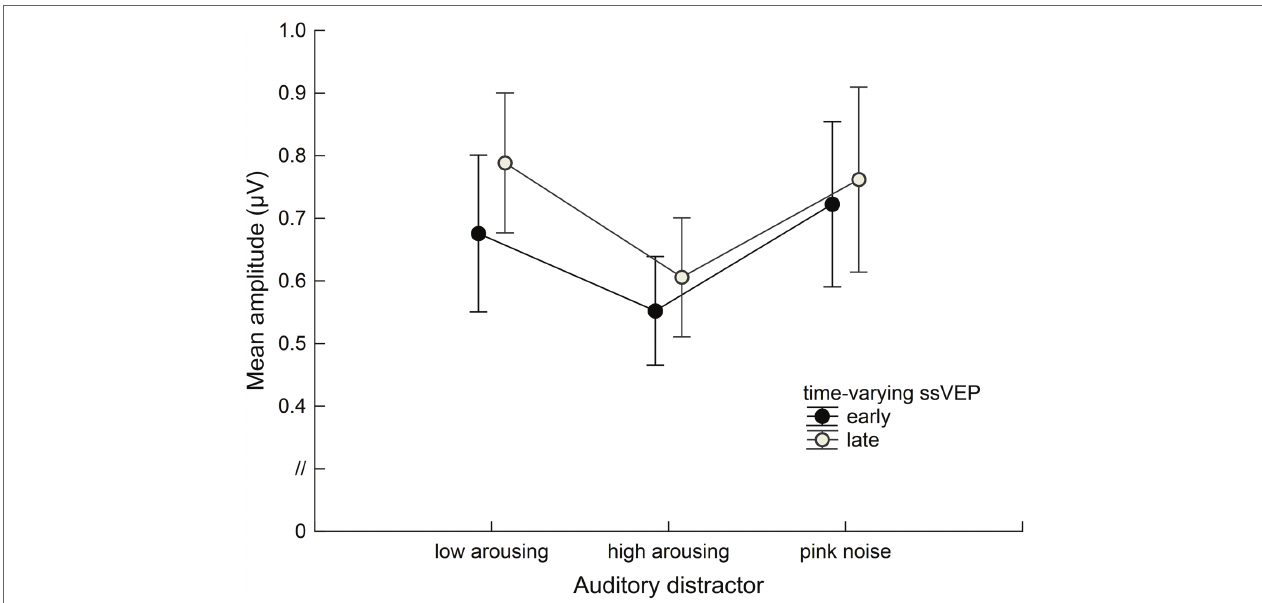
FIGURE 6 | Group data ( n = 20) for the time-varying ssVEP signal in the early and late time ranges. Mean amplitudes to the math-problem stream are shown as a function of auditory distractor type during early (400–2,600 ms) and late (3400–5,600 ms) time windows. Vertical bars indicate standard errors of mean. The presence of high-arousing sounds during math calculations was associated with diminished cortical responses compared to both low-arousing stimuli and pink noise. This distraction occurred across the time ranges of